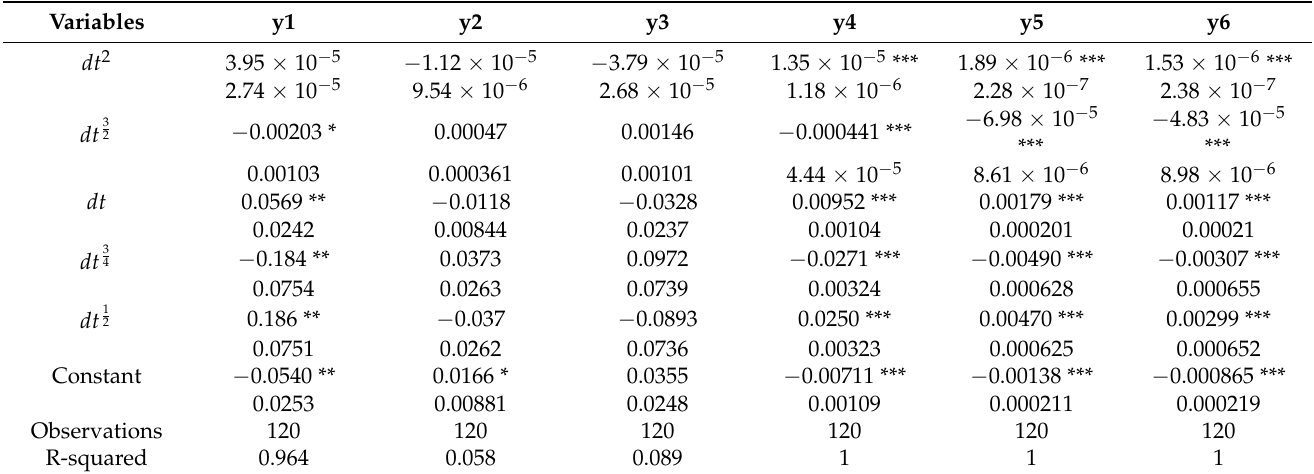
Table A1. Robustness Testing of Data Decomposition